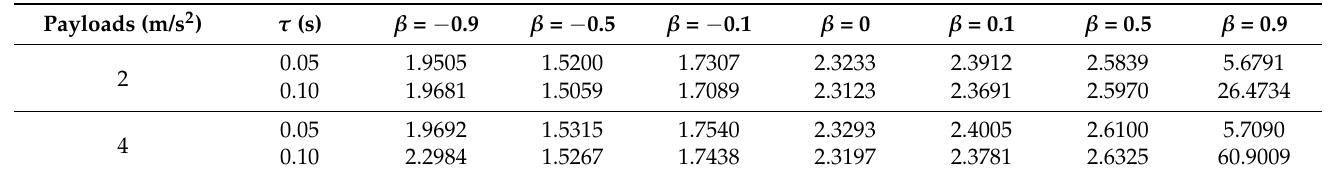
Table 15. Root mean squared value of the control signal u 2 in the first 30 s under different payloads, different input time delays and different fractional orders in the proposed controller.